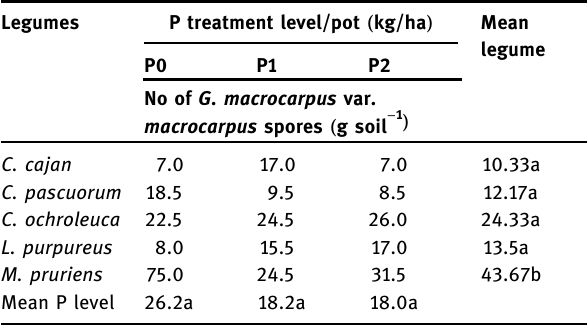
Table 5: E ff ect of phosphorus levels and studied legume species on spores of G. macrocarpus var. macrocarpus Legumes P treatment level/pot ( kg/ha )